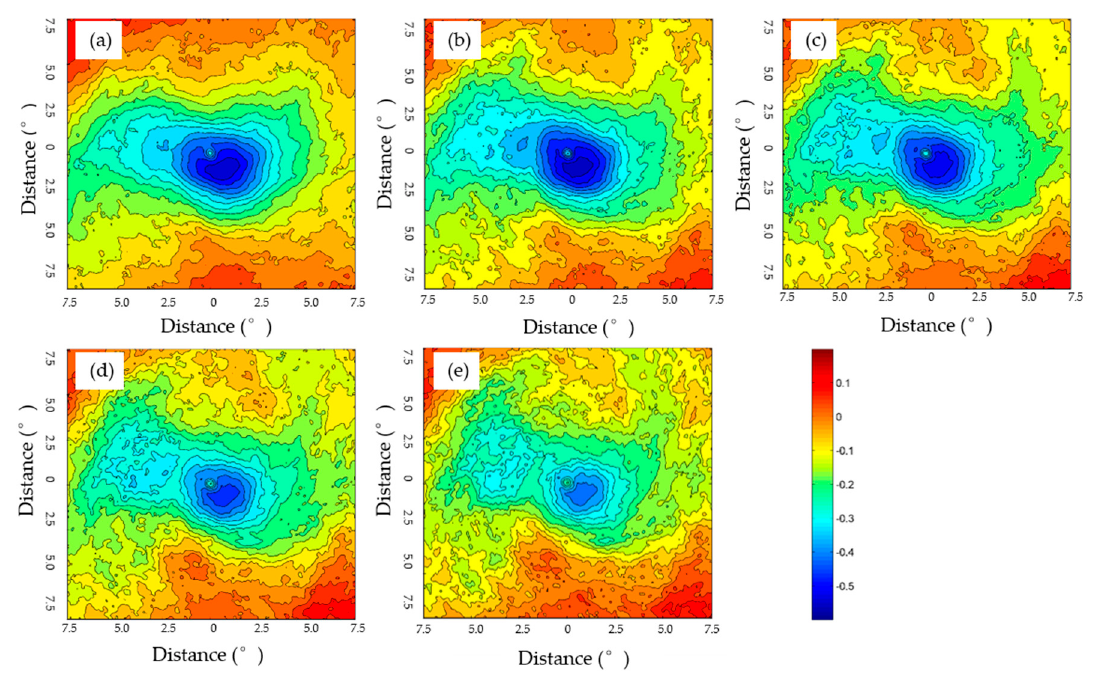
Figure 3. Correlations between South China Sea tropical cyclone (TC) intensity at various forecast lengths and the surrounding equivalent blackbody temperature (TBB). The center of each figure corresponds to the center of the TC. Forecast lengths depicted are ( a ) 0, ( b ) 6, ( c ) 12, ( d ) 18, ( e ) and 24 h.